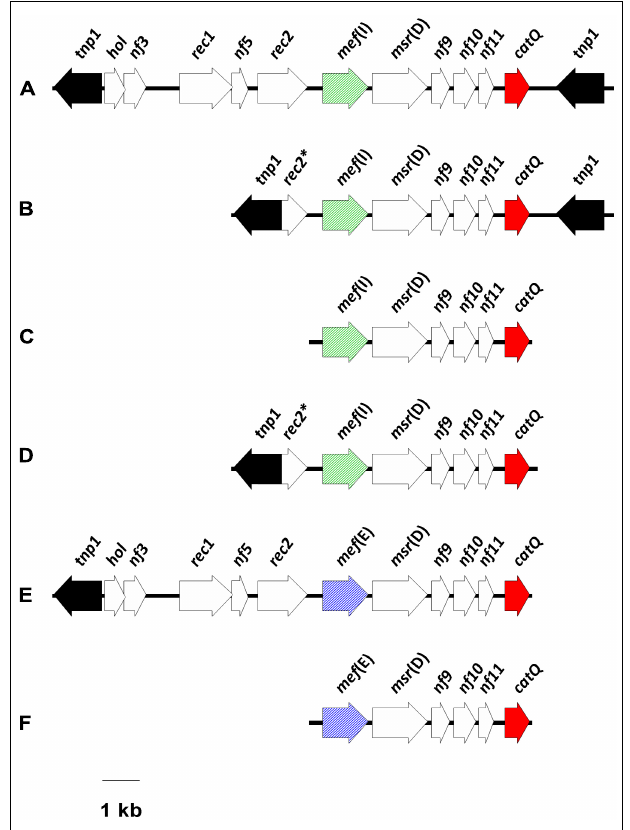
FIGURE 1 | Schematic illustration of the IQ modules detected so far in Streptococcus species. (A) S. pneumoniae ; prototype IQ module (Mingoia etal., 2007); (B) S. pyogenes (Del Grosso etal., 2011); (C) S. pyogenes (Del Grosso etal., 2011); (D) S. mitis (Brenciani etal., 2014); (E) S. oralis (Brenciani etal., 2014); (F) S. mitis , S. sanguinis , S. parasanguinis (Brenciani etal., 2014).The ORFs are depicted as arrows pointing in the direction of transcription: the mef gene is diagonally striped (green, mef (I); blue, mef (E)); catQ is red; the transposase gene tnp1 is black; and the other ORFs are